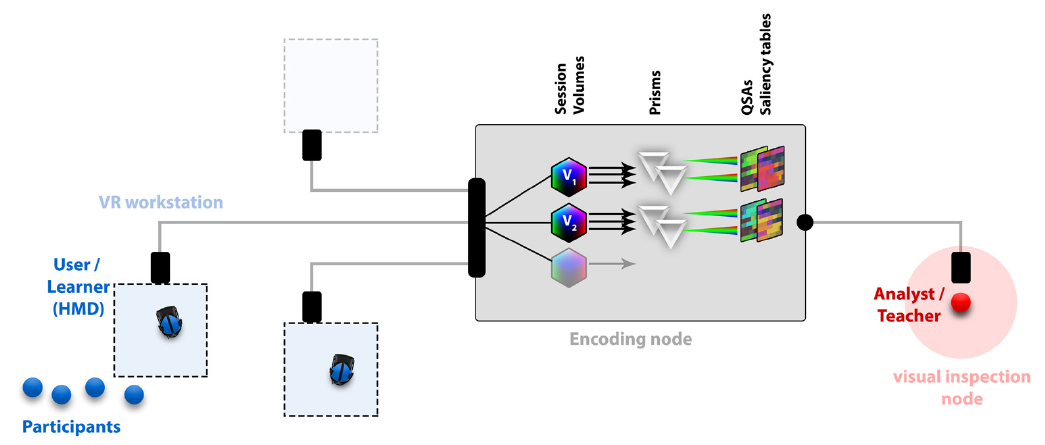
Figure 5. Architecture components